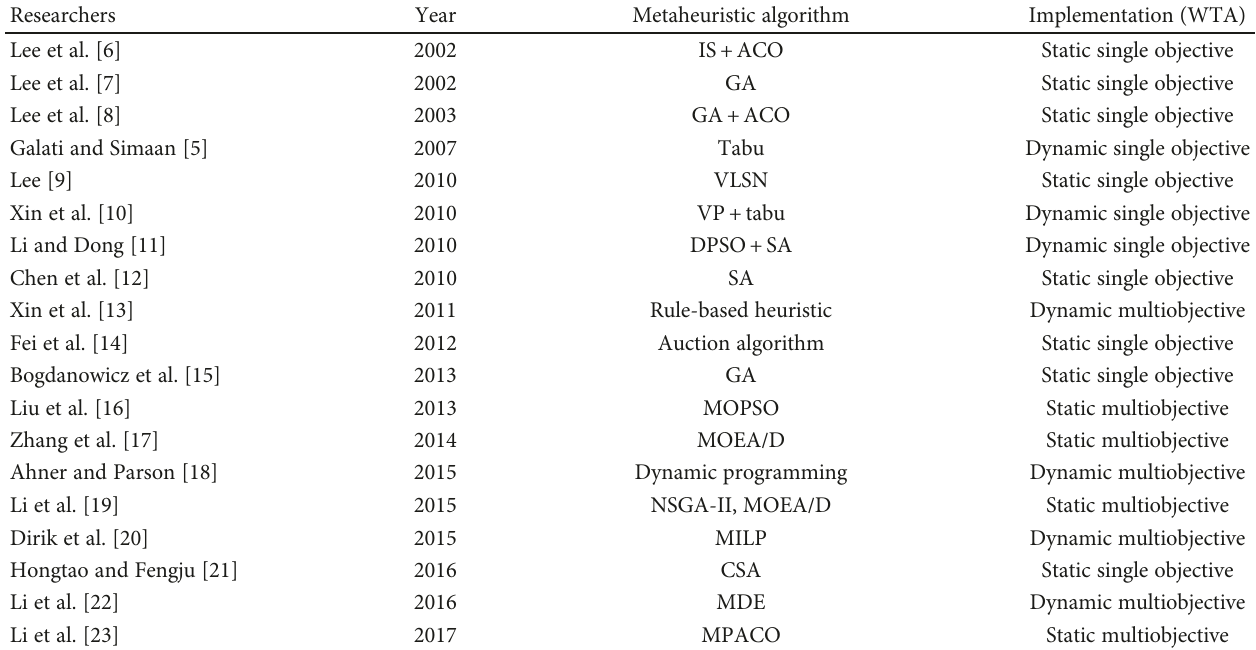
Table 1: Summary of variant metaheuristic algorithms and implementation of various WTA